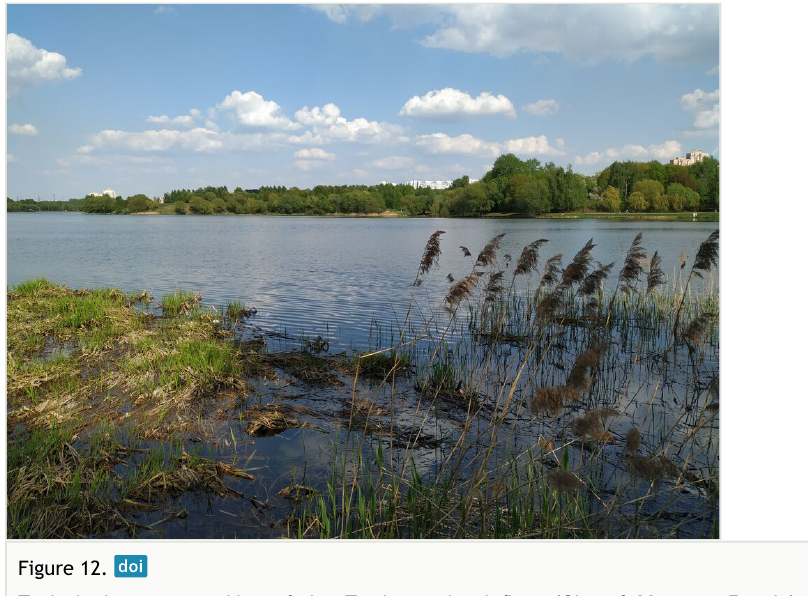
Figure 12. Typical plant communities of the Tsaritsyno local flora (City of Moscow, Russia): reed communities (Phragmito-Magnocaricetea) on the bank of a water reservoir. Photo by the author (2019).